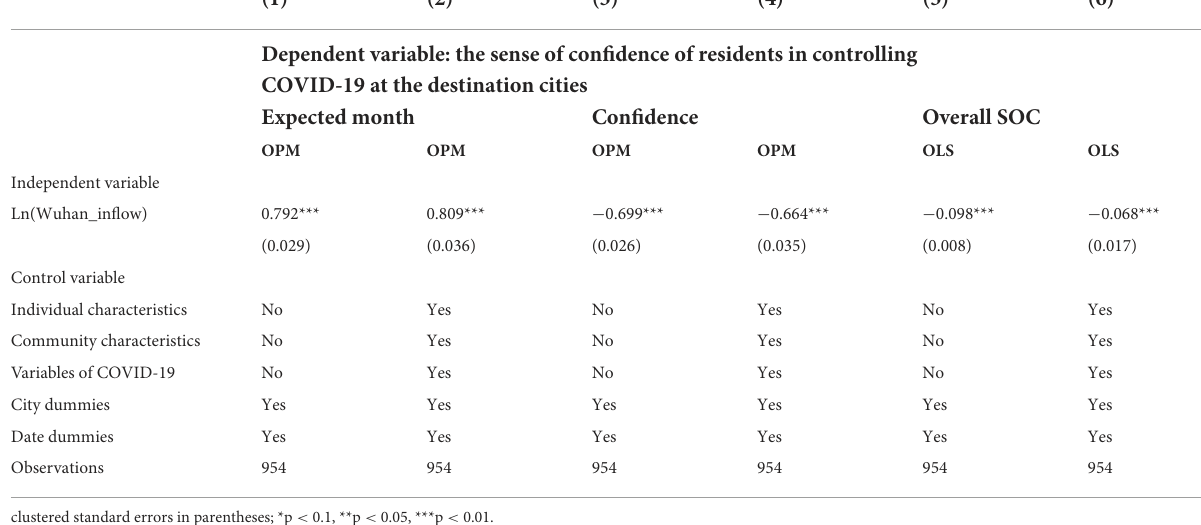
TABLE 6 Excluding the sample from Hubei province.